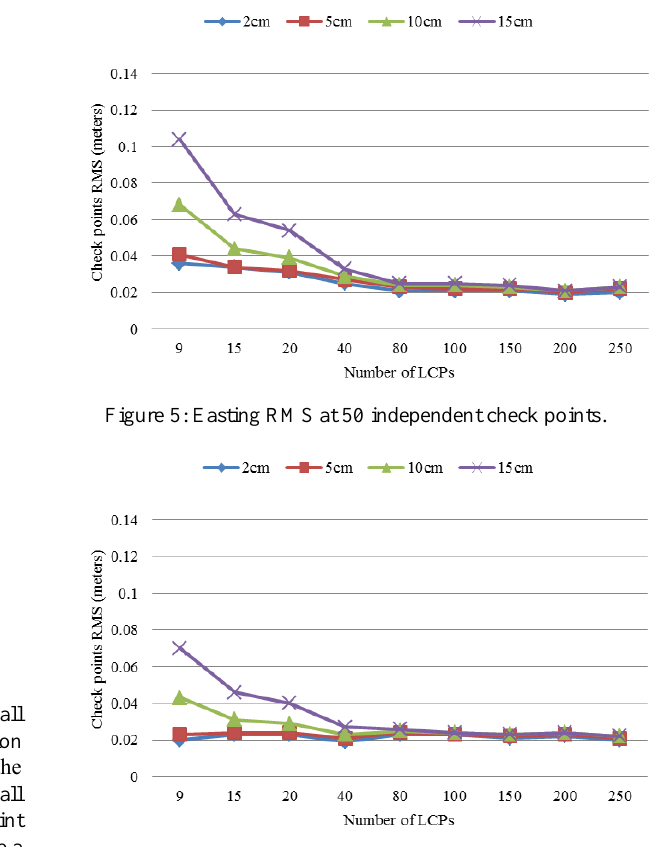
Figure 6: Northing RMS at 50 independent check